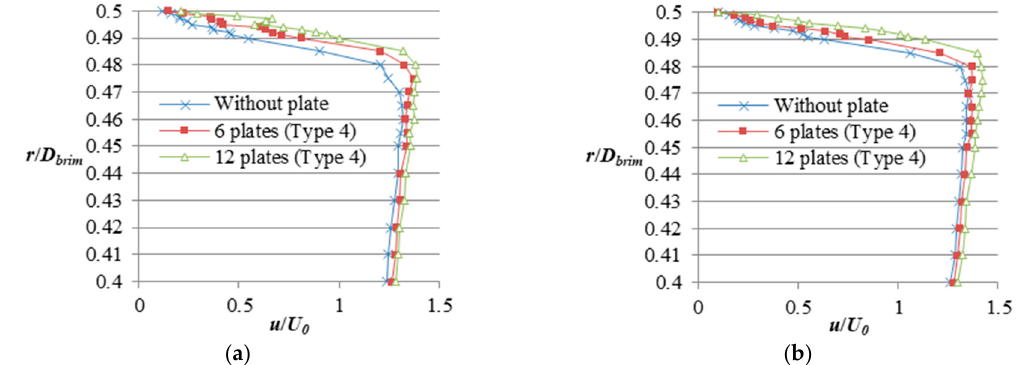
Figure 13. Nondimensionalized wind speeds in the streamwise direction near the inside wall of the WLT Ci10 duct (without the turbine): ( a ) Inflow wind speed U 0 = 4 m/s; ( b ) Inflow wind speed U 0 = 8 m/s.